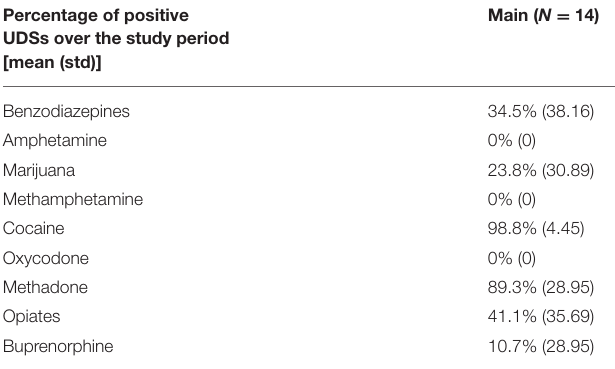
TABLE 7 | Summary of urine drug